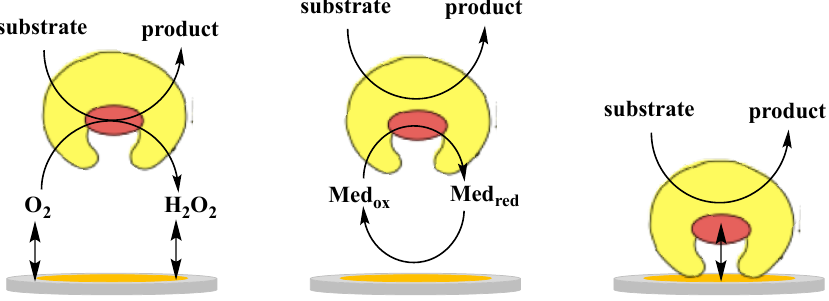
Figure 1. Schematic representation of electron transfer in biosensors: 1st generation ( left ), 2nd generation with soluble or immobilised mediator ( centre ) and 3rd generation ( right ).